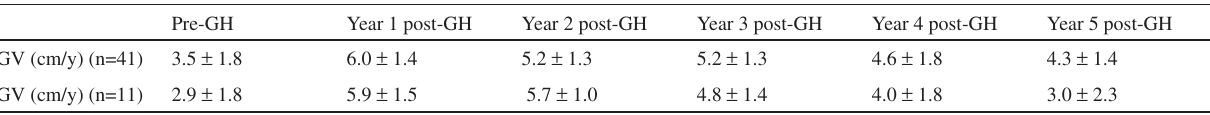
Table 1 - Growth velocity in TS girls before and after treatment with GH